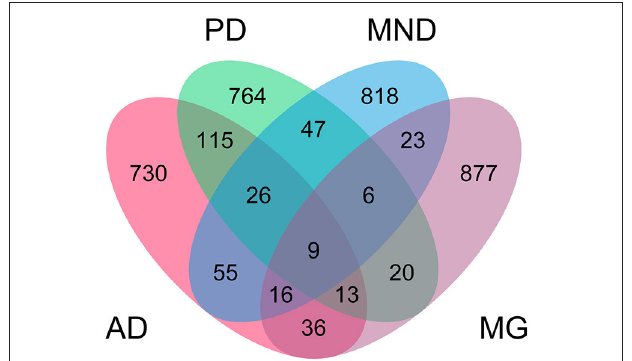
FIGURE 4 | Distribution of shared SNPs across neurological diseases. The top 1,000 SNPs identified by genome-wide association study with Alzheimer’s disease (AD), Parkinson’s disease (PD), motor neuron disease (MND), and myasthenia gravis (MG) were inspected for overlap across multiple diseases. Numbers indicate number of SNPs shared between